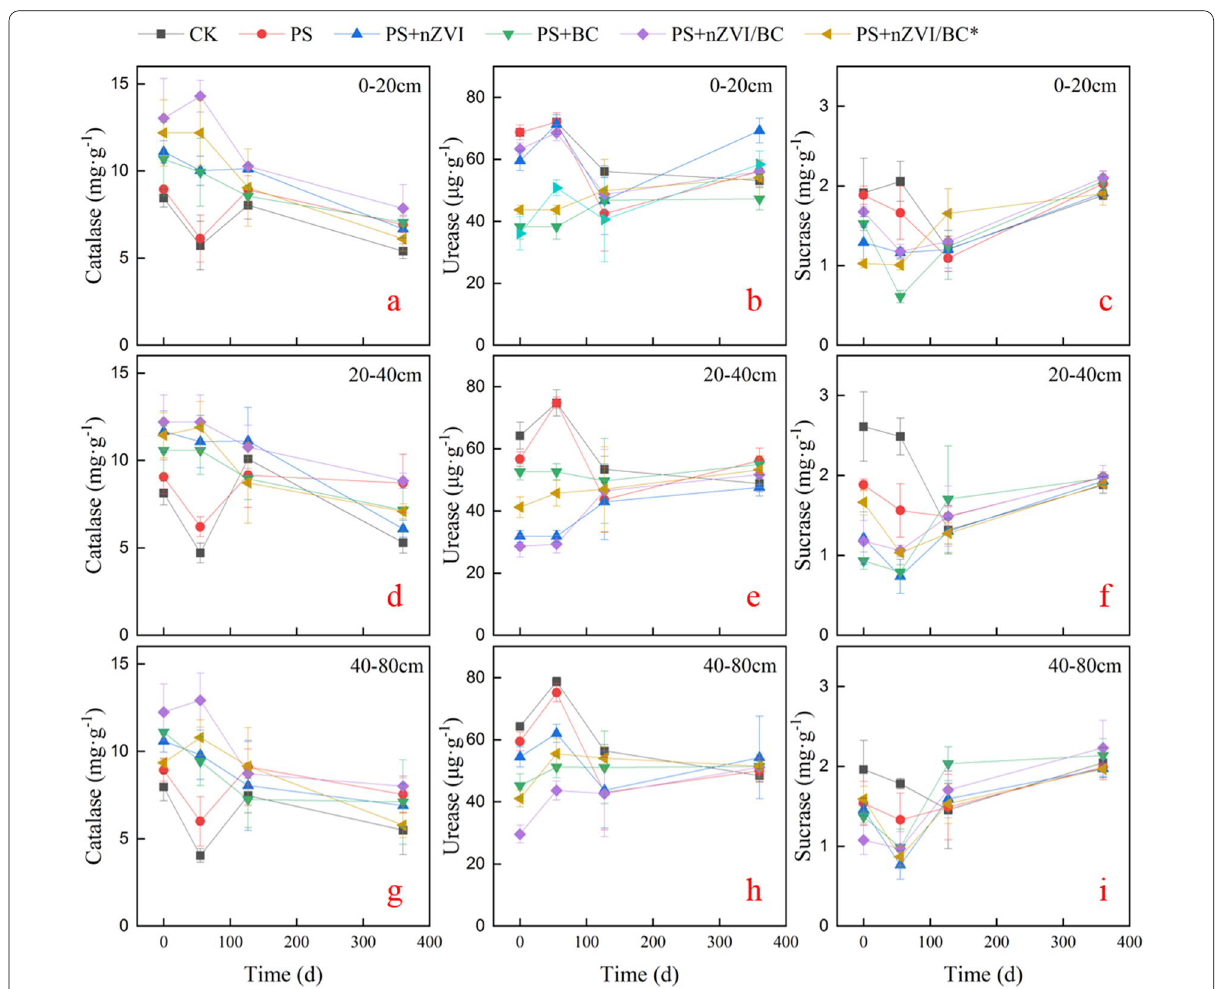
Fig. 5 Soil enzyme activities ( a , d , g catalase; b , e , h urease; c , f , i sucrase) in different remediation cells at different depths of soil. PS: 0.2 g kg − 1 ;